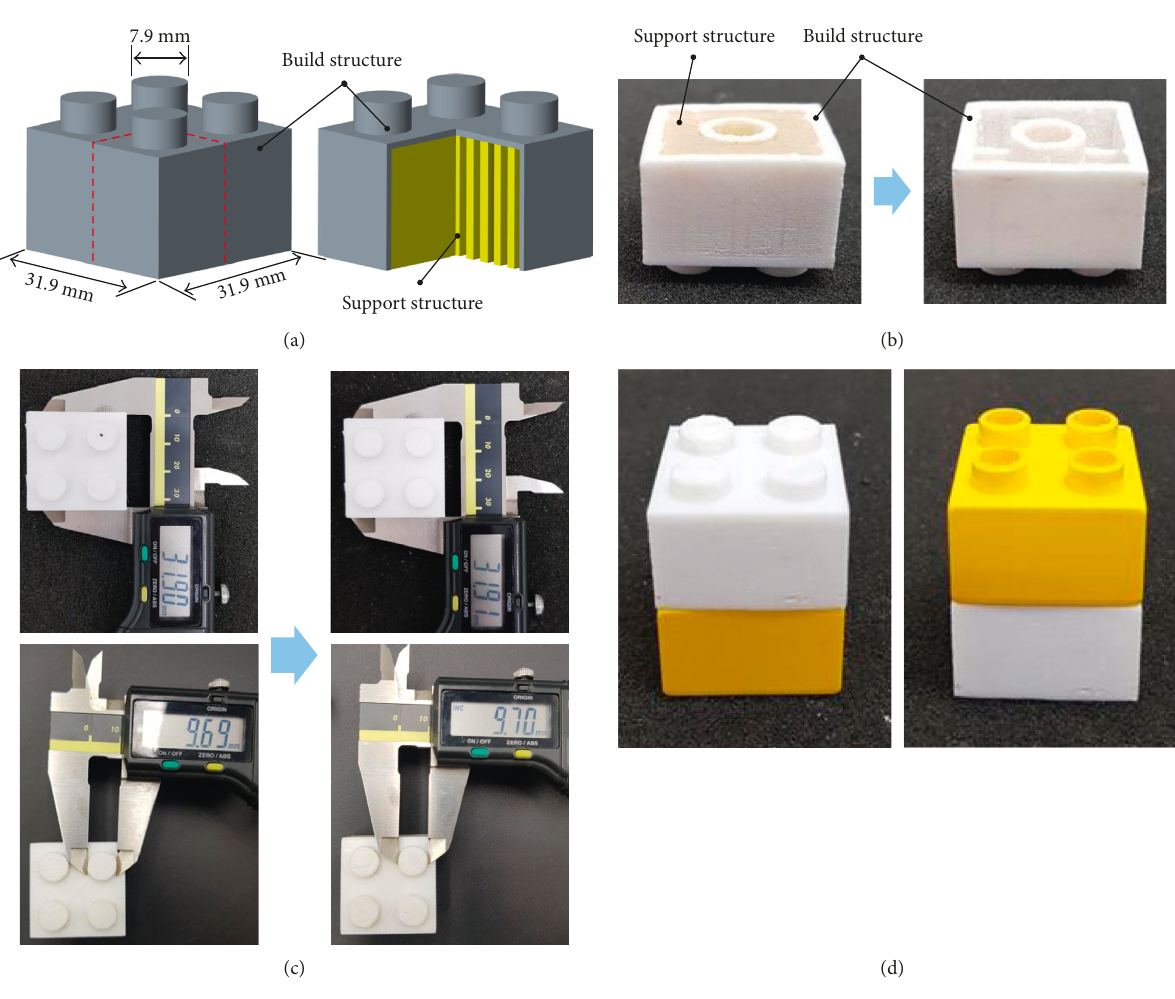
Figure 11: (a) A CAD model of a Lego structure composed of build and support parts. (b) The dual-printed structure including a PC build part and a PVA support part. (c) Comparison of the dimensions of the printed part before and after dissolution of the PVA support. (d) Assembly of the H 2 O 2 -treated part with an original Lego part with an identical